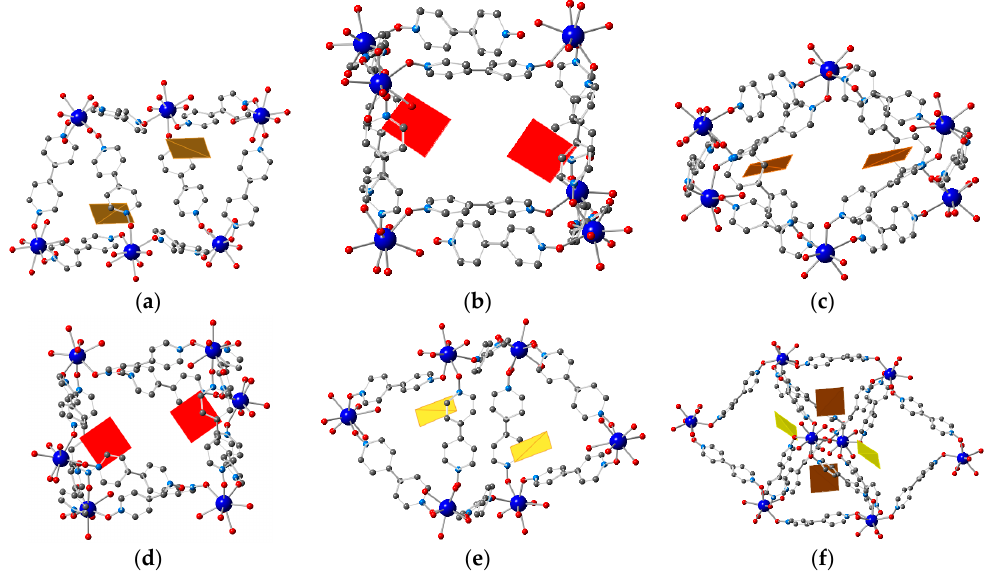
Figure 6. Different environments of the crystallographically independent [AuCl 4 ] − anions after anion exchange ( a – f ).